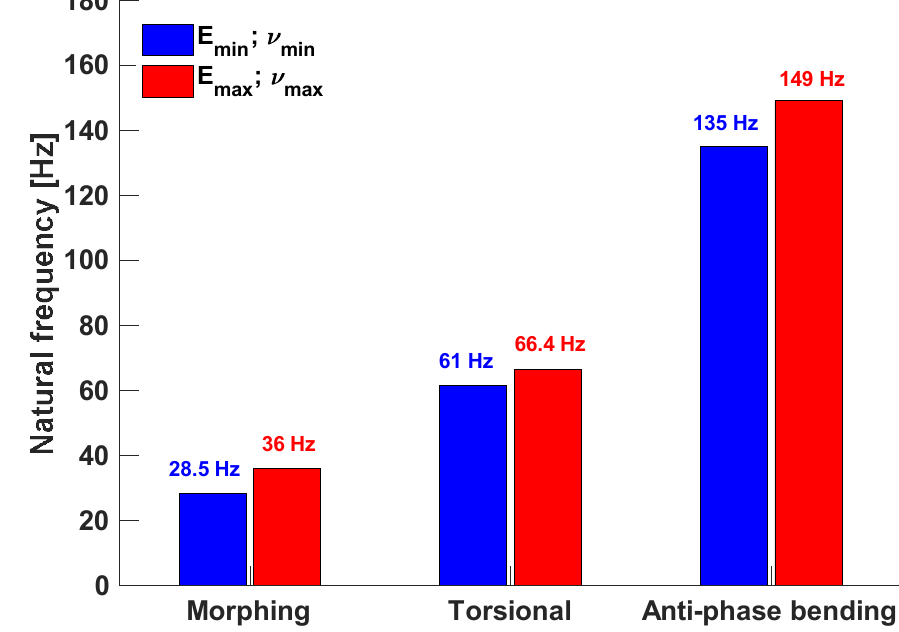
Figure 18. Parametric normal modes analysis: natural frequencies of the first three elastic modes.